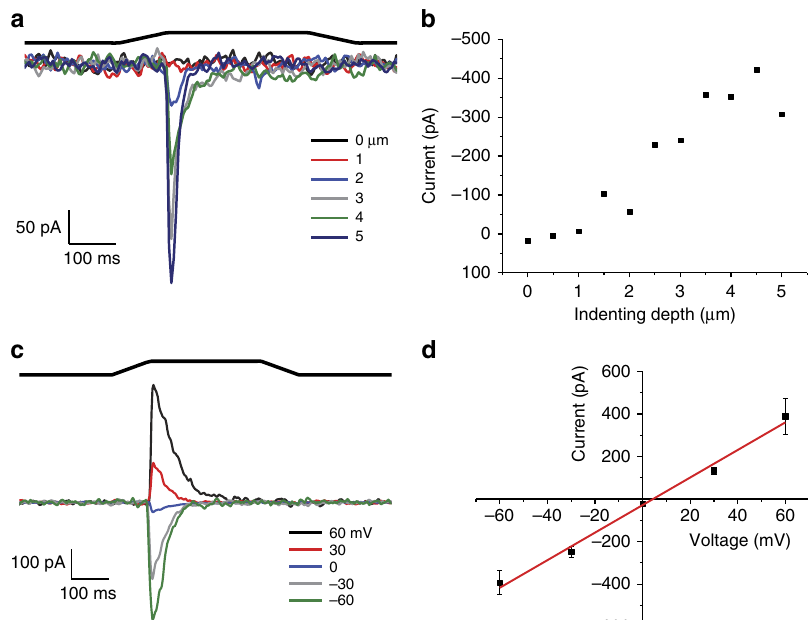
Figure 6 | Whole-cell recording for PIEZO1–1591–mCherry on HEK293 cells produce robust currents. ( a ) Whole-cell currents elicited by pressing on the cell with a glass probe to the indicated depths. The membrane voltage was set to (cid:2) 60mV. Above the current trace is the stimulus waveform. ( b ) Current plotted as a function of depth, which was incrementally increased at 0.5 micron intervals. Increased depth increases the current. ( c ) Currents recorded when the probe is set to single depth at varying membrane potentials. ( d ) Current as a function of voltage (from c ) showing that the reversal potential is near 0mV as in the wild-type PIEZO1 channel (data points represent mean ± s.e.m.; n ¼ 5).